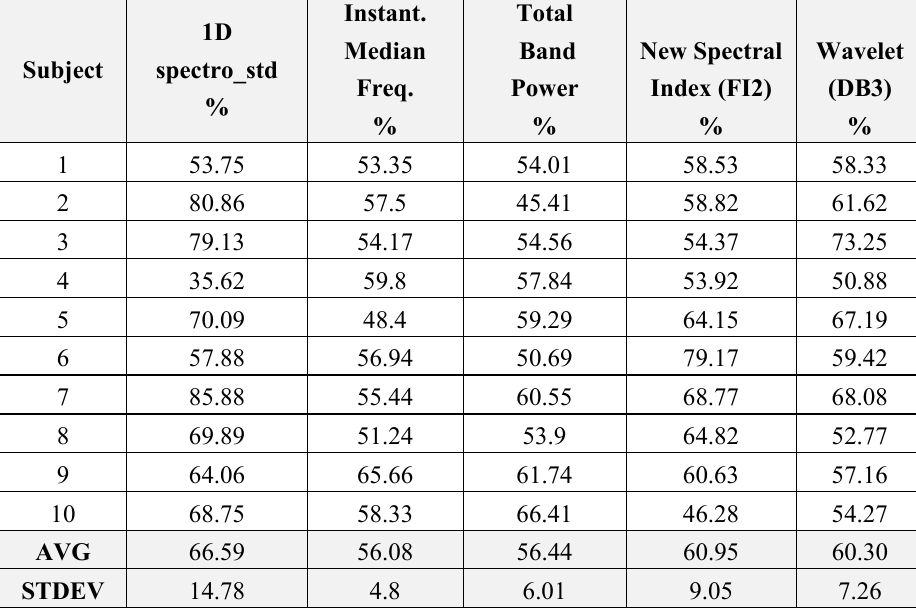
Table 5. Percent correct classification for Transition-to-Fatigue and Fatigue for the various features within subjects.